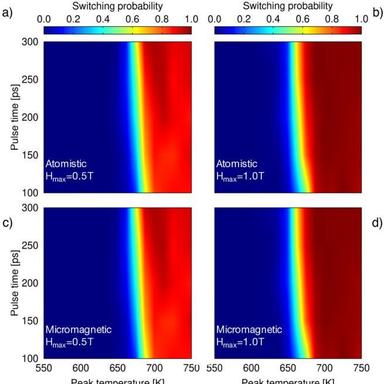
Switching probability as a function of peak temperature for various pulse lengths for both micromagnetic and atomistic simulations. Adapted from Ref..